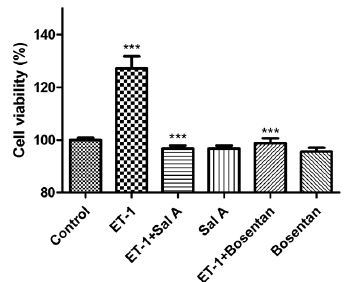
Figure 6. Growth response of prostate cancer cell lines to ET-1 (10 nM) and Sal A (10 µM, ET A receptor antagonist) and Bosentan (10 µM, ET A , and ET B receptor antagonist). After 48 h incubation with compounds, cell viability (%) was compared with controls (set at 100%). Bosentan and Sal A significantly reduced growth in the presence of exogenous ET-1 (vs. ET-1 group). Without the